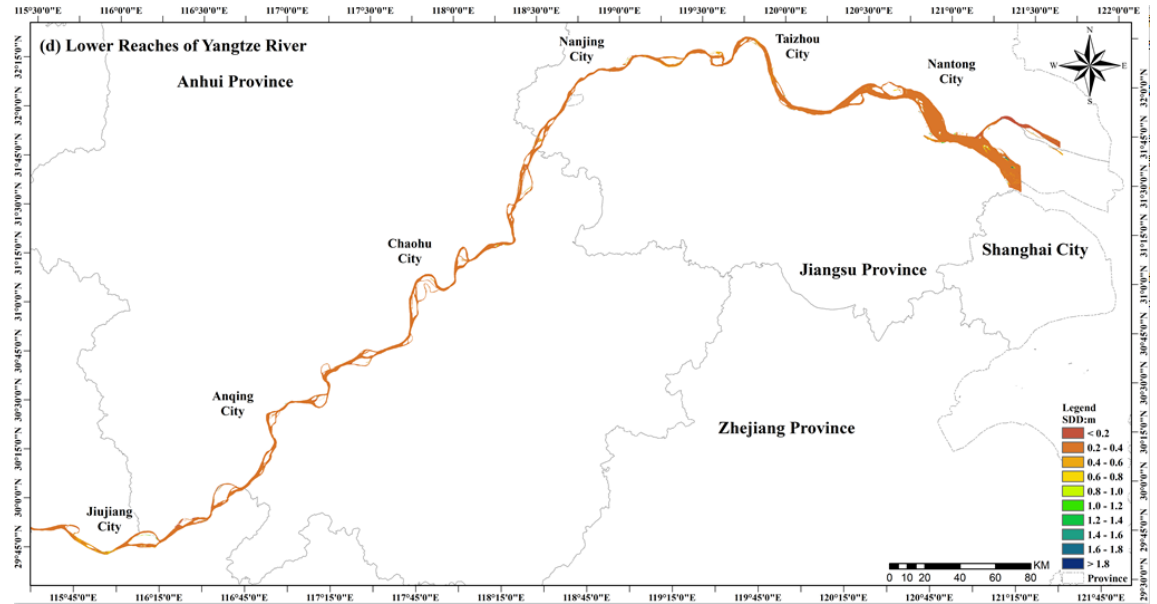
Figure 6. Spatial distribution of SDD in 2017–2020; ( a ) Yangtze River full view; ( b ) upper reaches; ( c ) middle reaches; ( d ) lower reaches of Yangtze River.